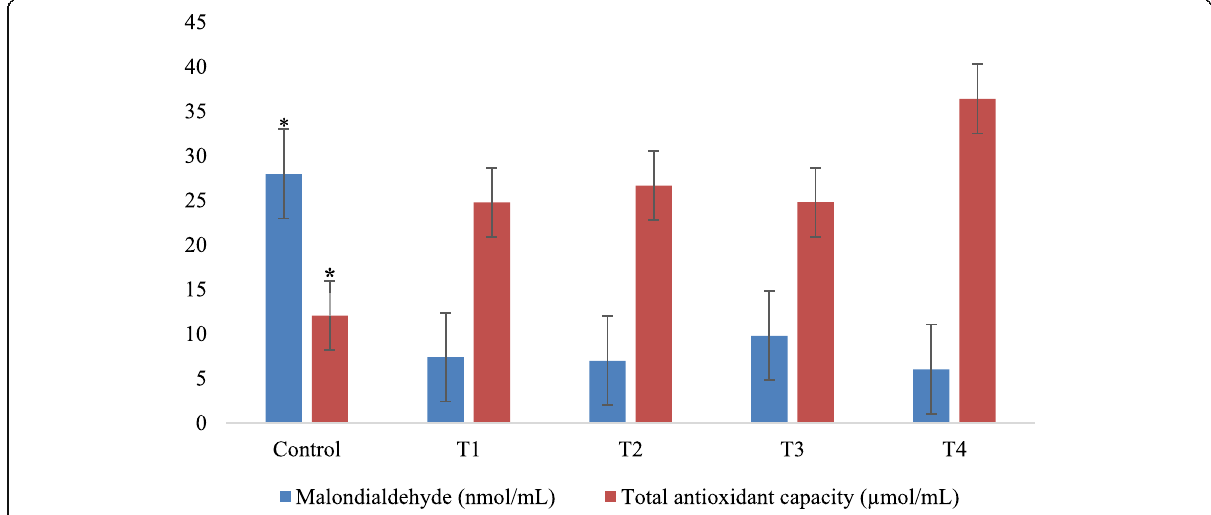
Fig. 2 Comparative effect of Chlorella vulgaris on lipid peroxidation and total antioxidant capacity of the rabbits (* p < 0.05). Control — no supplementation, T1 — group supplemented with 200 mg Chlorella vulgaris biomass, T2 — group supplemented with 300 mg Chlorella vulgaris